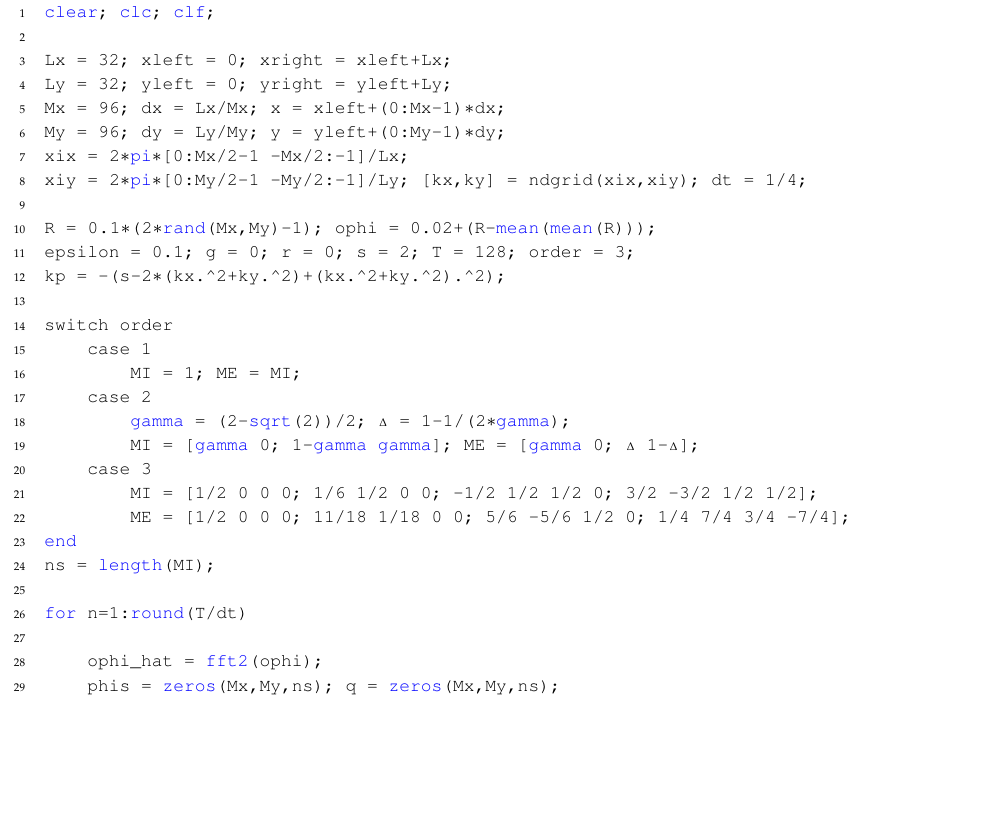
Figure 12. Evolutions of